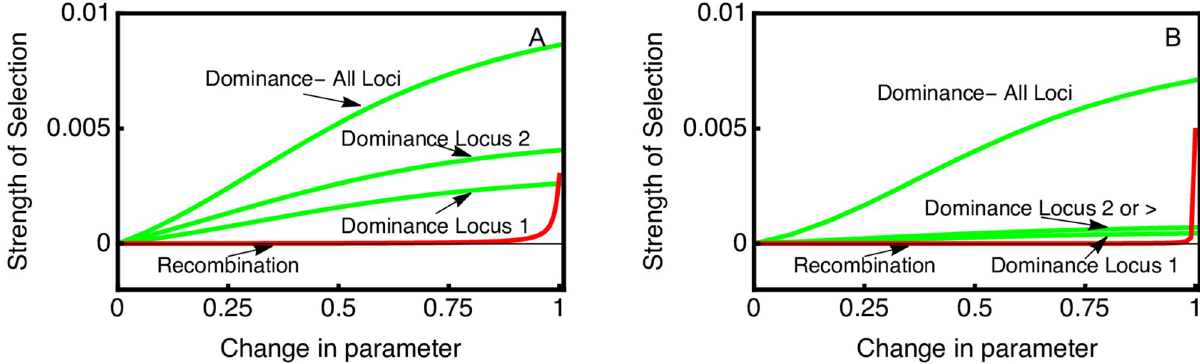
Fig 4. Strength of selection on dominance modifiers is dependent on modifier linkage. Parameter values for the ancestral population are S = 0.1, M = 0.05, R = 0.5; θ = 0; ϕ = 0. In Panel (A) 2 loci contribute to local adaptation. The green curves show selection on a modifier that simultaneously affects dominance of all loci, or a modifier that affects dominance of the locus tightly linked to the modifier (locus 1) or a locus that freely recombines with the modifier (locus 2). In panel (B) 5 loci contribute to local adaptation. Loci 2–5 all freely recombine with the modifier, and so selection on modifiers that affect dominance at any of these loci have the same strength of